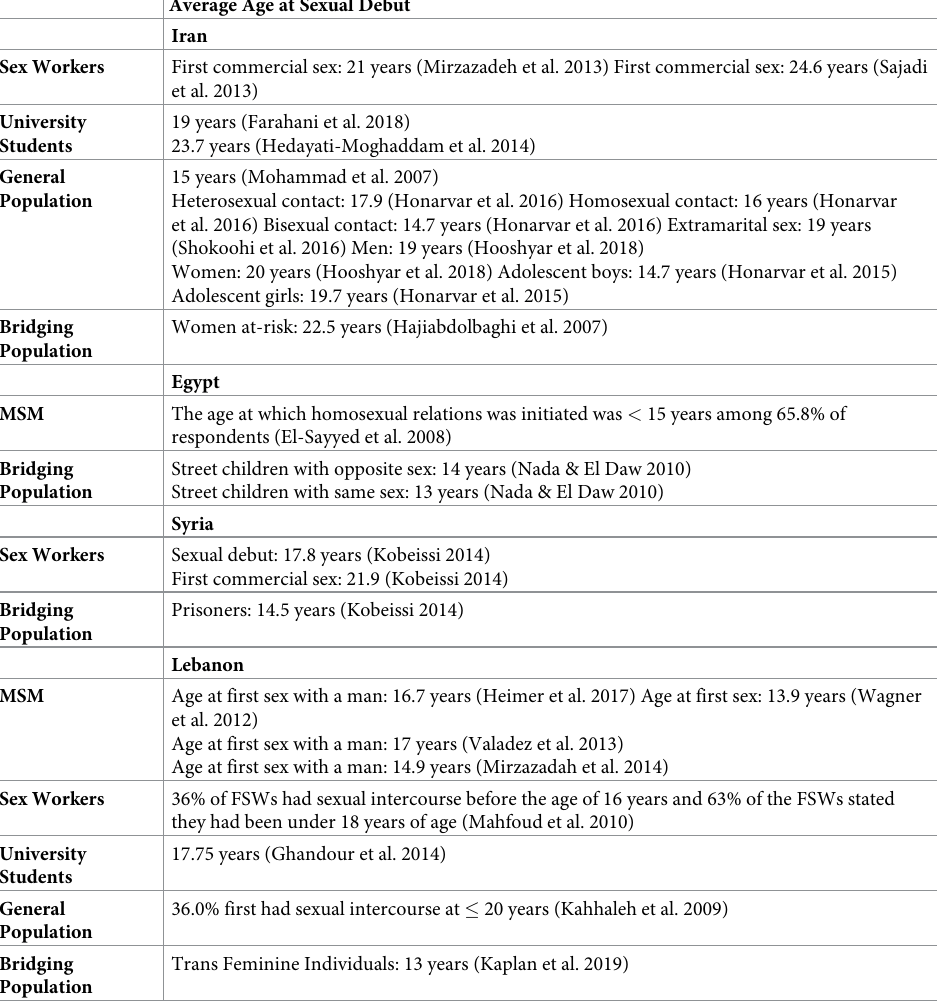
Table 3. Average age at sexual debut among youth population groups in the MENA